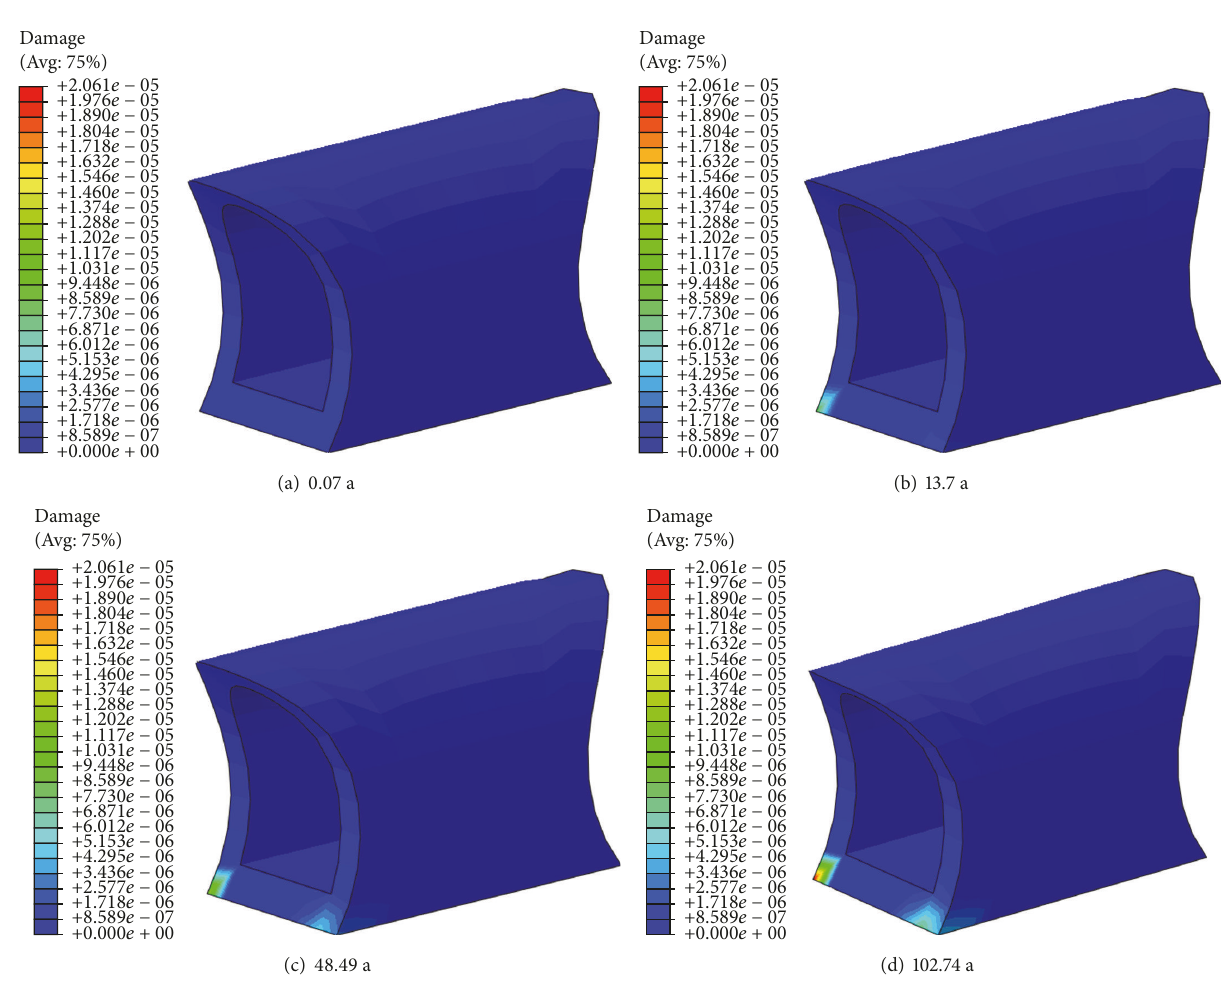
Figure 18: Compressive damage nephogram of the connecting transverse passage at different operation times.